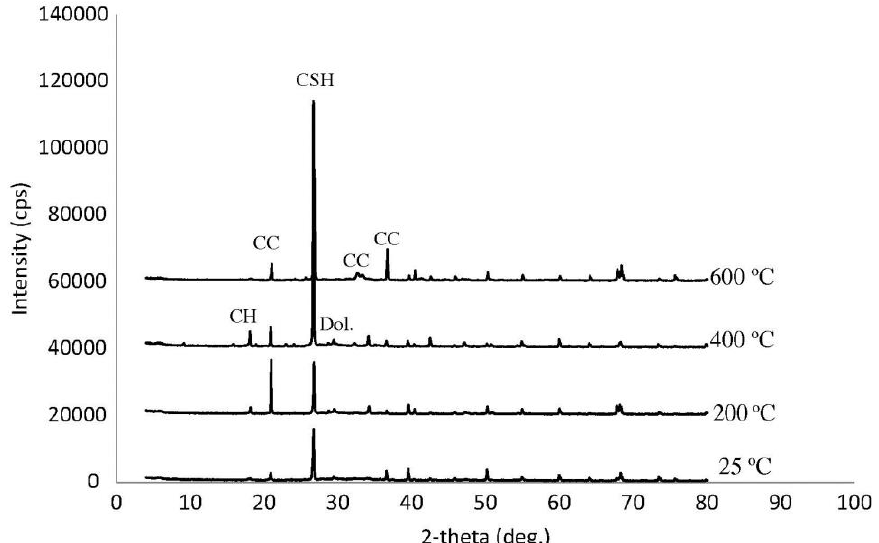
Figure 2. XRD patterns of mortar with 2% untreated hydrophilic montmorillonite nanoclay after exposure to different temperatures [18] (Reprinted/adapted with permission from Ref. [18]. Copyright 2020, ELSEVIER).